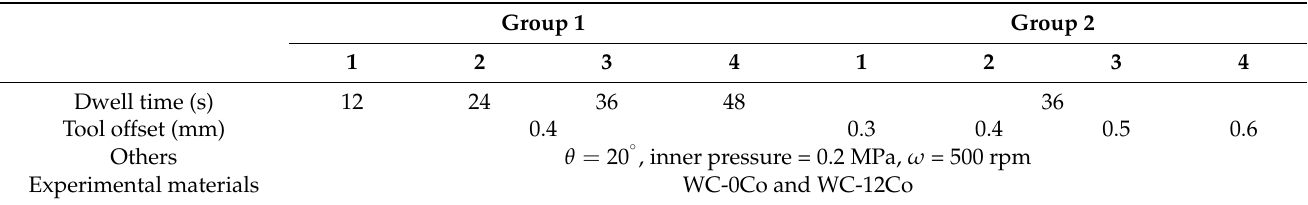
Table 1. TIF generation conditions.